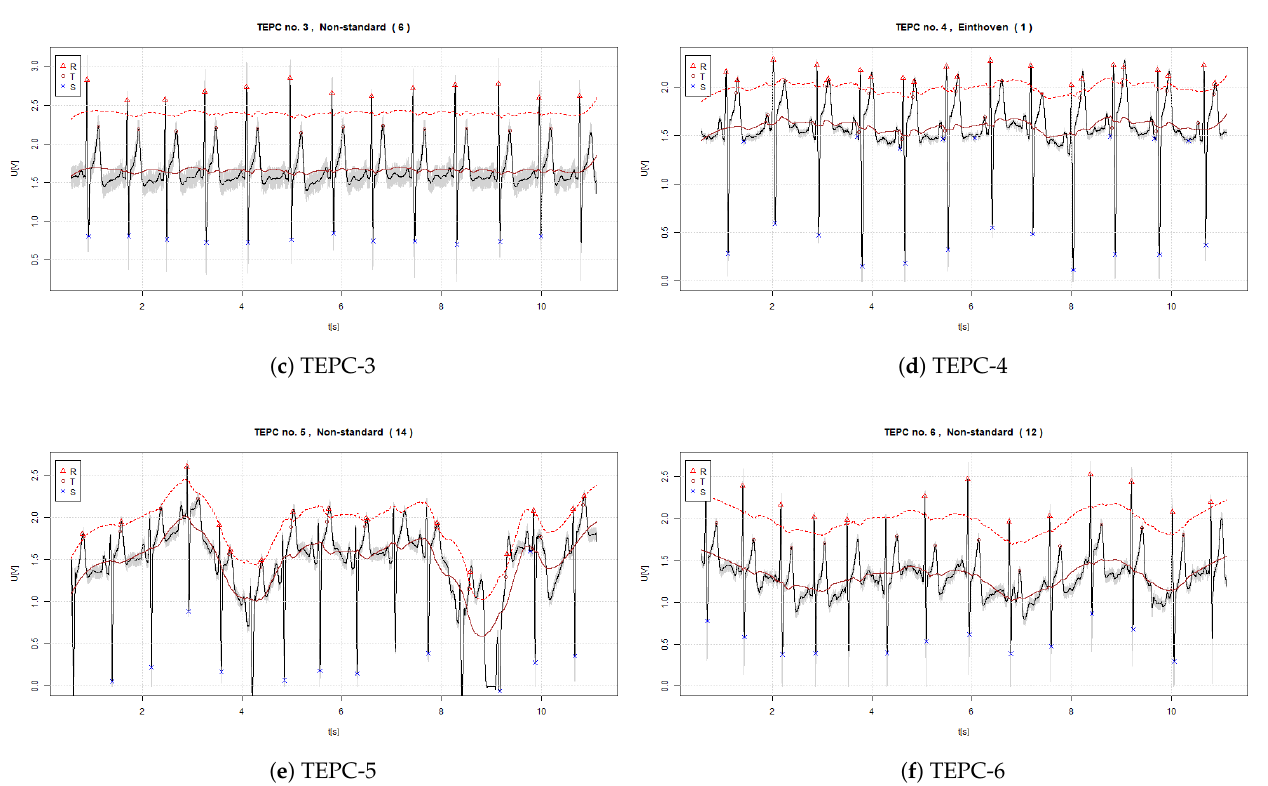
Figure 6. Measured signals of ECG that are acquired by using the TEPC1-6 (where the continuous red line denotes the baseline and dashed red line 60% threshold level). In the graphs, the continuous red line denotes the midpoint (0-point) of the signal. The dashed red line denotes the threshold value of 60% from the 0-point. The legend for determined R, S, and Q waves is shown in each figure.